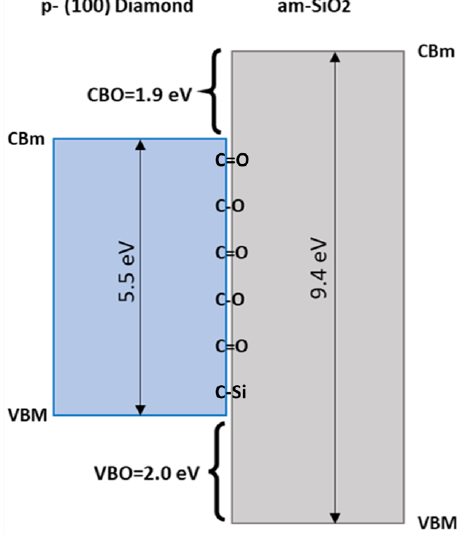
Figure 5. Scheme of the band alignment between SiO 2 and O-terminated (100)-oriented p-type diamond showing its interfacial